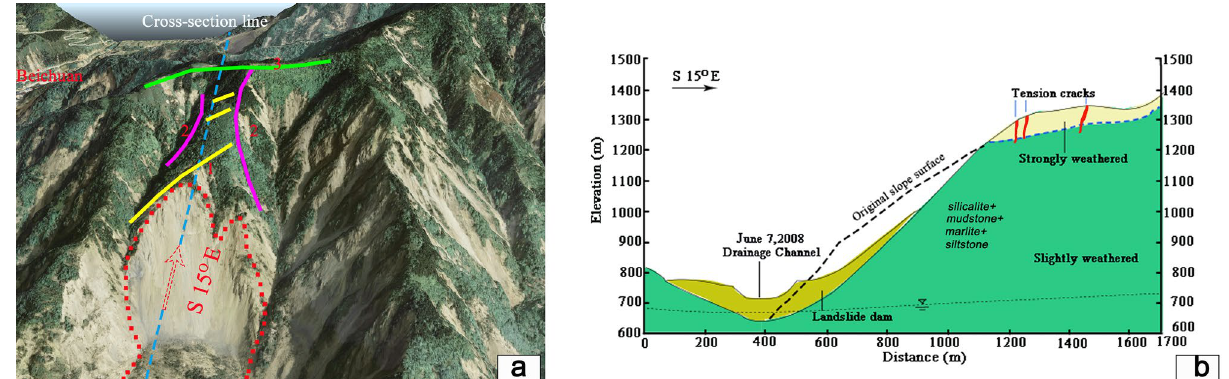
Figure 4. ( a ) Distribution of cracks in the residual mountain after landslide; ( b ) Engineering geological profile through the Tangjiashan landslide and landslide dam. Google Earth Pro 7.3 (https ://www.googl e.com/intl/en/ earth /) was used to generate the ( a